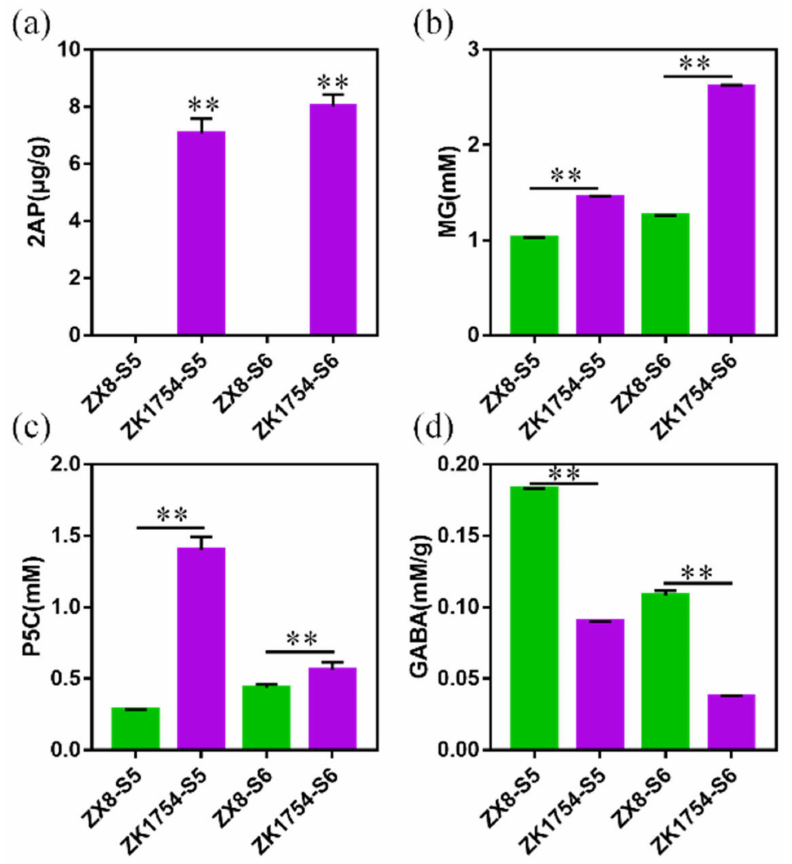
Figure 4. The content of 2AP and the main metabolites of its synthetic pathway. ( a ) 2AP content. ( b ) MG content. ( c ) P5C content. ( d ) GABA content. ** Indicates significance at the p < 0.01